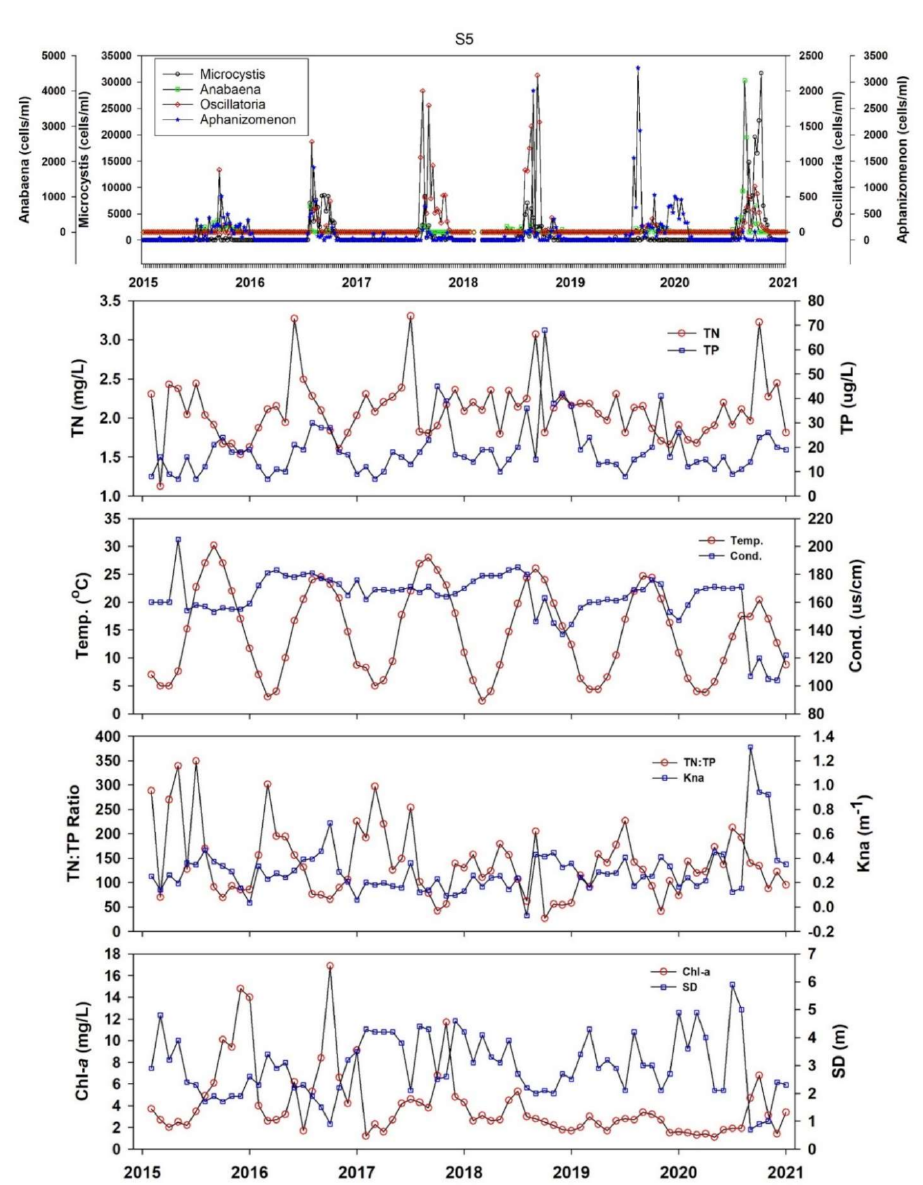
Figure A1. Comparison between the blue-green algae species, nutrients, water temperature and non-algal light attention coefficient (Kna) during 2015–2020 at the IT 2, i.e., Site